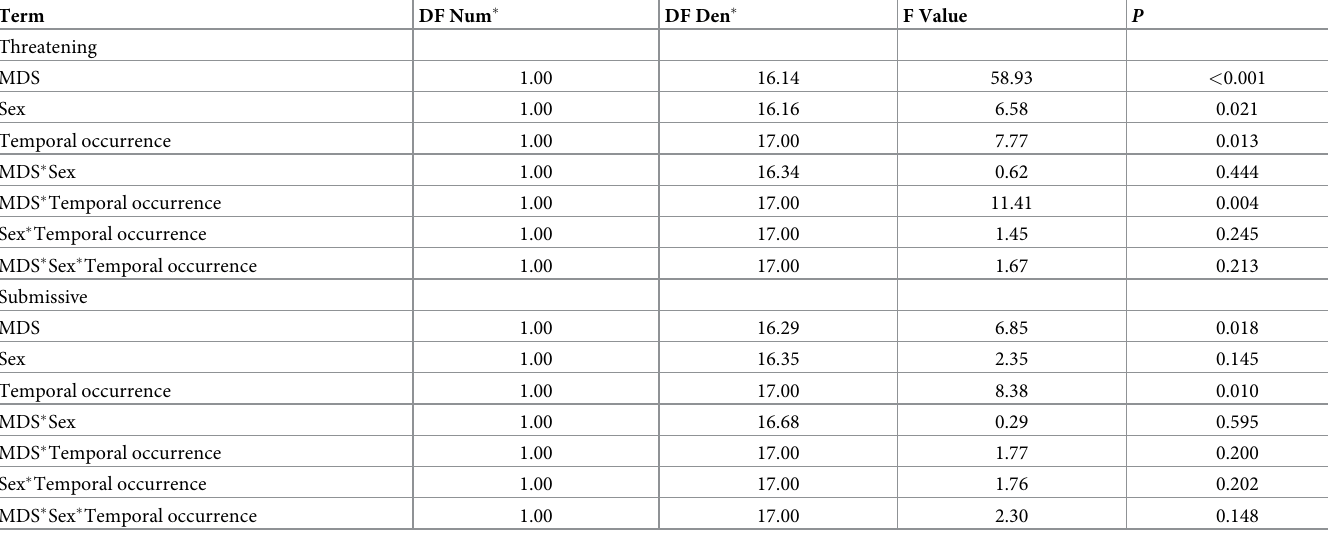
Table 3. Effect of the senders’ social rank (modified dominance David’s scores–MDS), sex, and temporal occurrence (after failure using unimodal signal or indepen- dent of a previous failure) in the production of unimodal and multimodal signals by white-lipped peccaries (N =